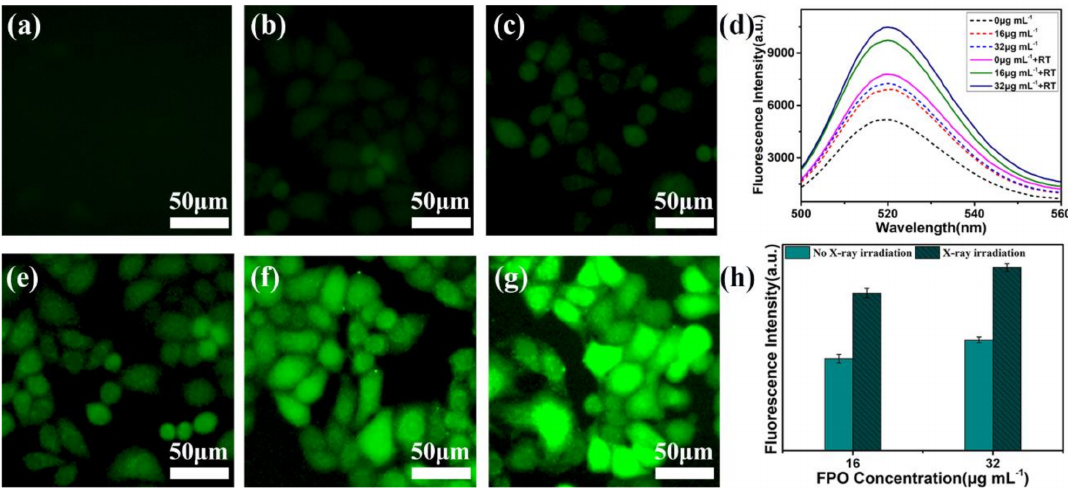
Figure 10. The fluorescence images of 4T1 cells with different treatment: ( a ) cell cultured with only DCFH-DA as the control group; ( b ) FPO@HMSNs-PAA (16 µ g · mL − 1 ) without RT; ( c ) FPO@HMSNs-PAA (32 µ g · mL − 1 ) without RT; ( e ) RT (55 kV, 8 mA) without sample; (55 kV, 8 mA); and, ( d , h ) the comparison of fluorescence intensity in 4T1 cells with different